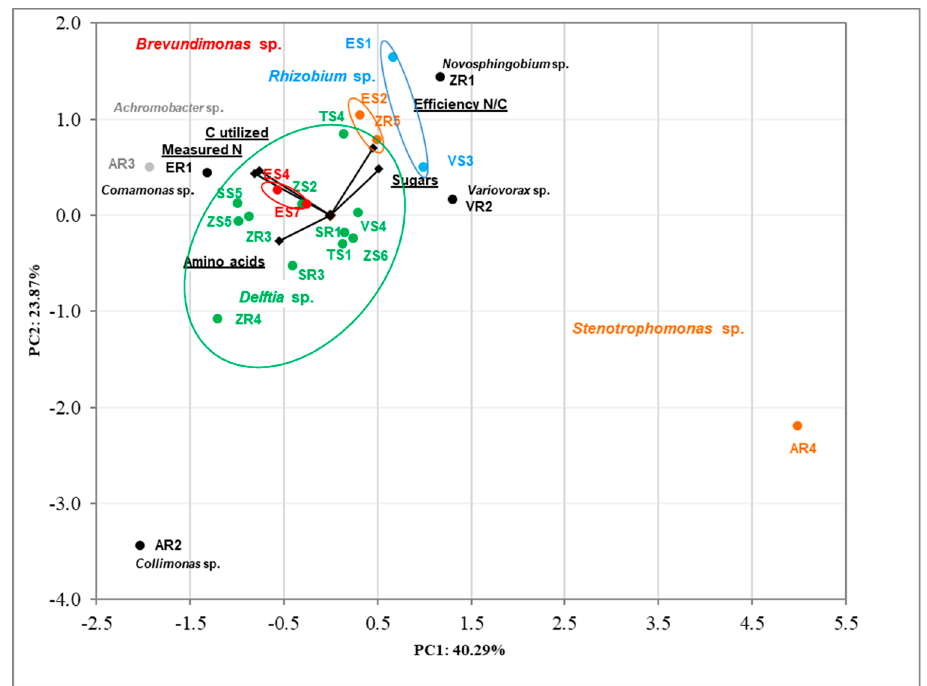
Figure 4. Biplot diagram of Principal Component Analysis (PCA), describing amino acids and sugar utilization, efficiency of nitrogen fixation and nitrogen produced, carbon utilized for 23 bacterial endophytes isolated from plants. Strains classified based on the nucleotide sequence of their 16S rRNA genes to the same genus are indicated in different colors.